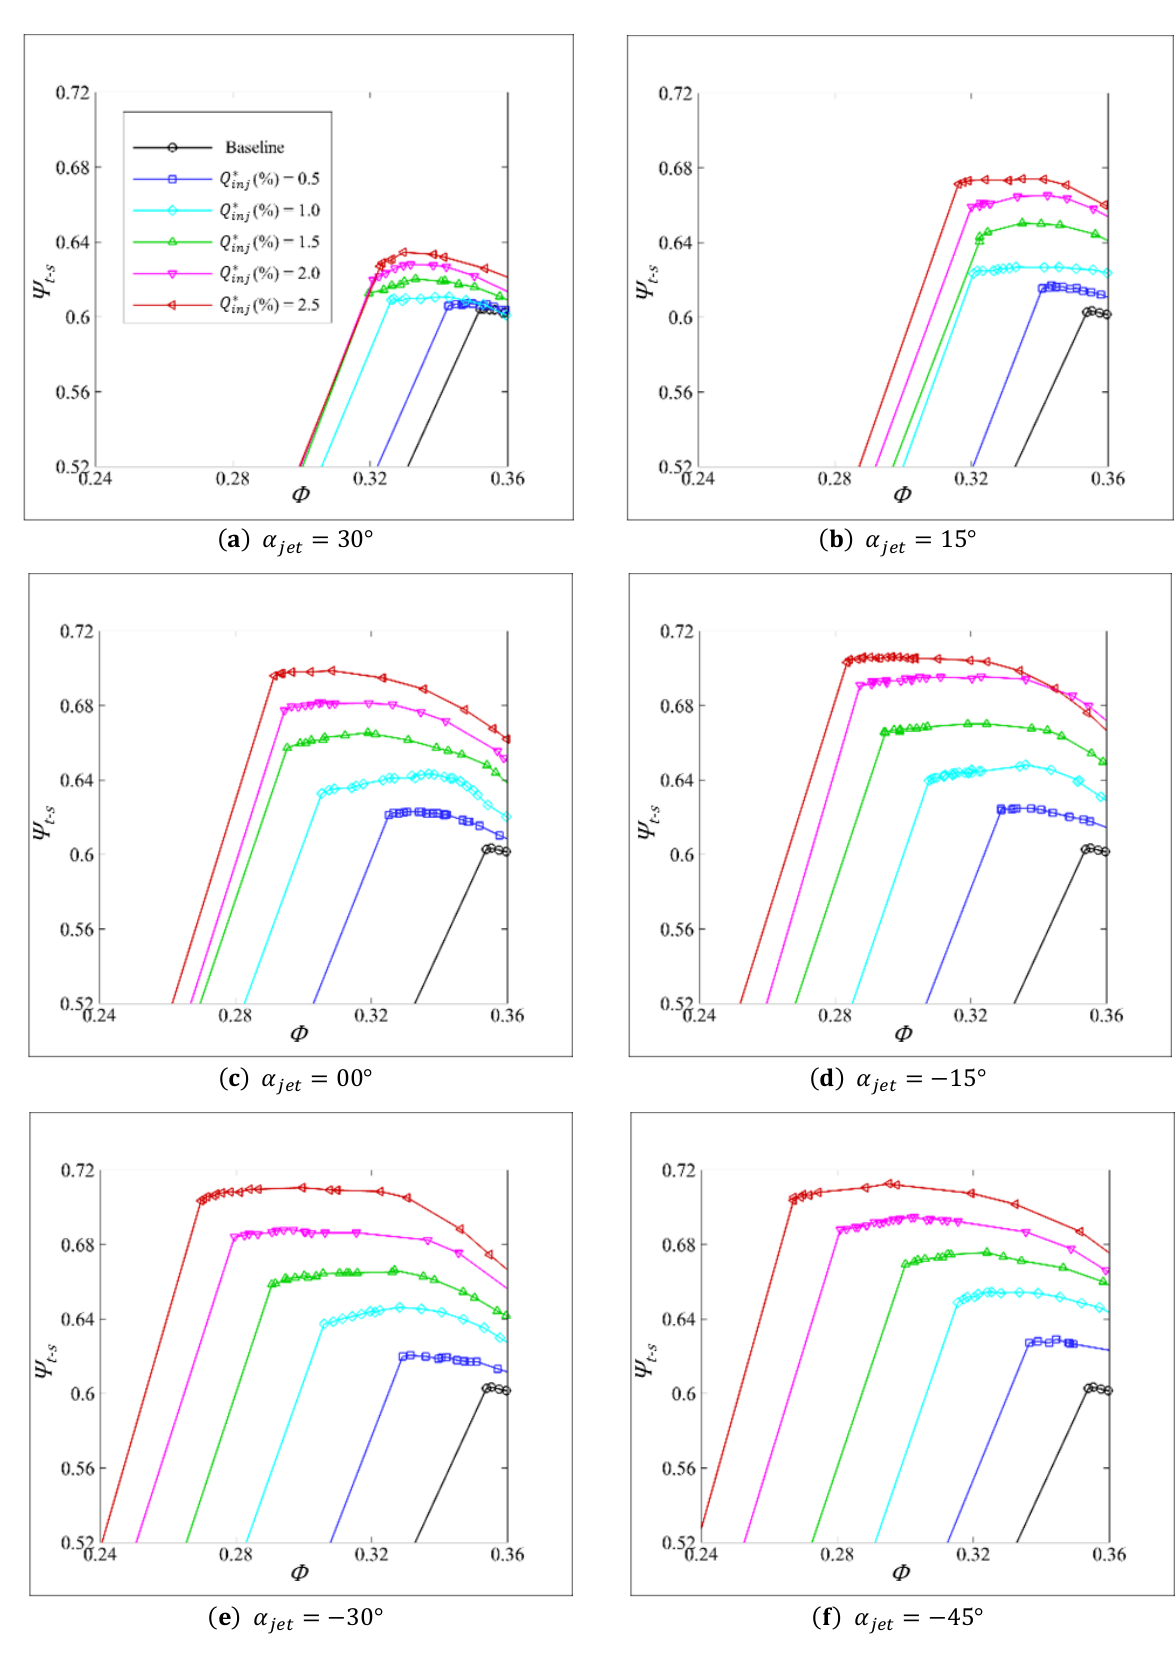
Figure 6. Performance curves obtained using continuous blowing with various absolute blowing angles of: ( a ) 30 ◦ , ( b ) 15 ◦ , ( c ) 0 ◦ , ( d ) − 15 ◦ , ( e ) − 30 ◦ and ( f ) − 45 ◦ and various injected mass flow rate values (40 injectors activated and rotation speed 𝛺 = 3200 rpm) .